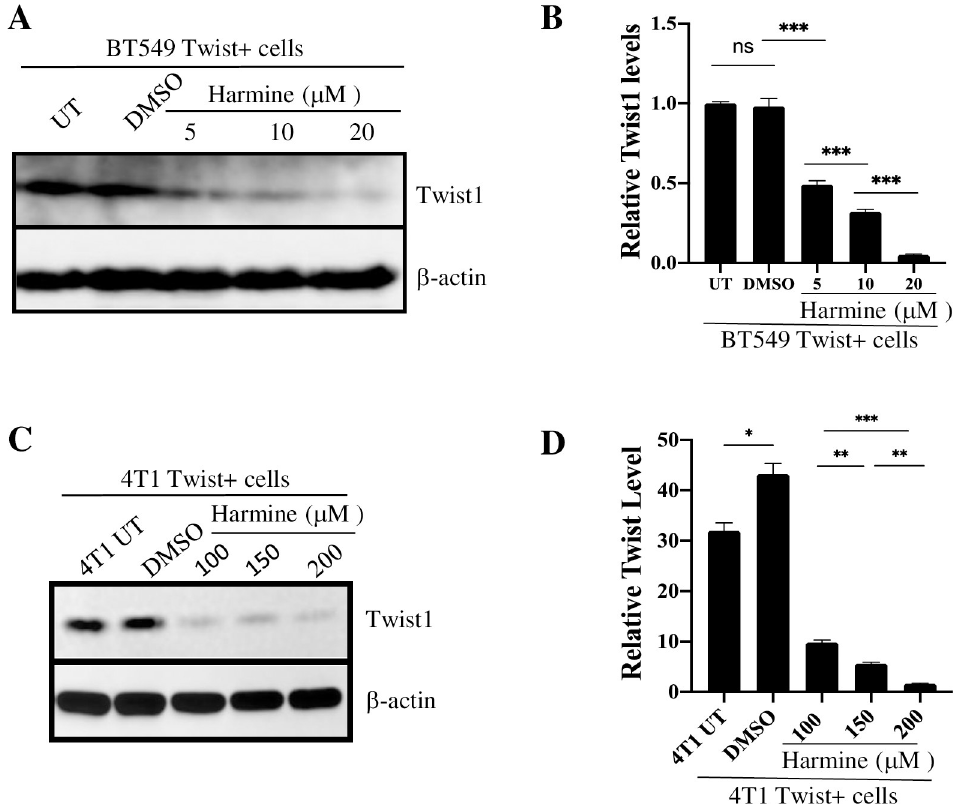
Fig 4. Harmine induces a dose-dependent degradation of Twist1 in breast cancer cells. A, The BT549 Twist+ cells were either untreated (UT), treated with DMSO, or treated with harmine at the concentrations indicated for 48 hr. Cell lysates were analyzed by blotting for Twist1 or β -actin (loading control). B, Quantitative analysis of result shown in A. C, The 4T1 Twist+ cells were either untreated (UT), treated with DMSO, or treated with harmine at the concentrations indicated for 48 hr. Cell lysates were analyzed by blotting for Twist1 or β -actin (loading control). D, Quantitative analysis of result shown in C. Definitions of statistical significance are � p < .05, �� p < .01, ��� p < .001, and ���� p <